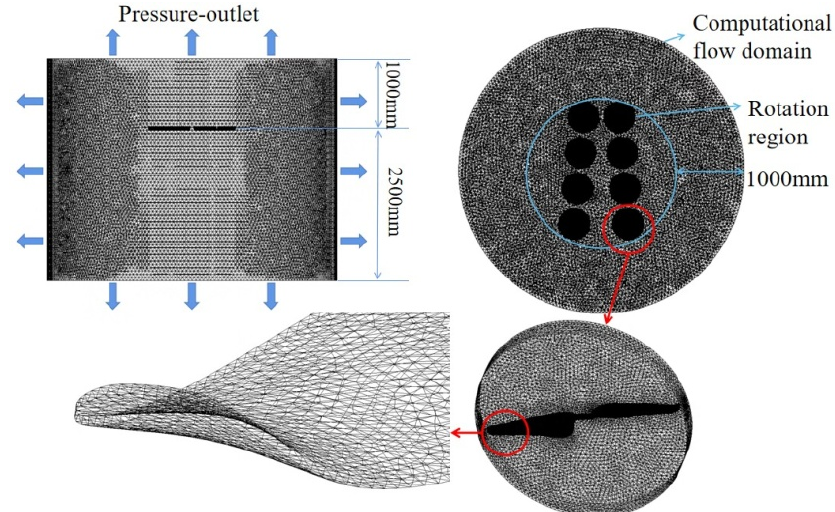
Figure 5. Computational domain.